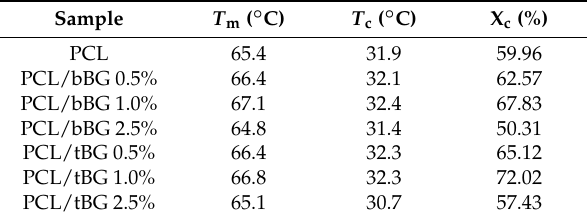
Table 2. Thermal characteristics of PCL and its nanocomposites as measured by